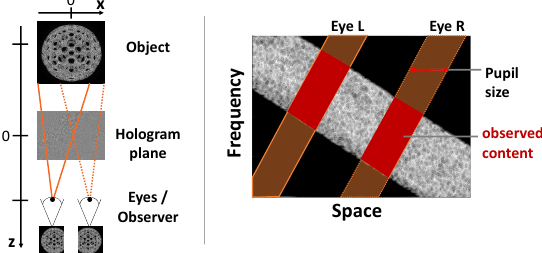
Figure 14. The concept of binocular vision and eye PSFs in phase